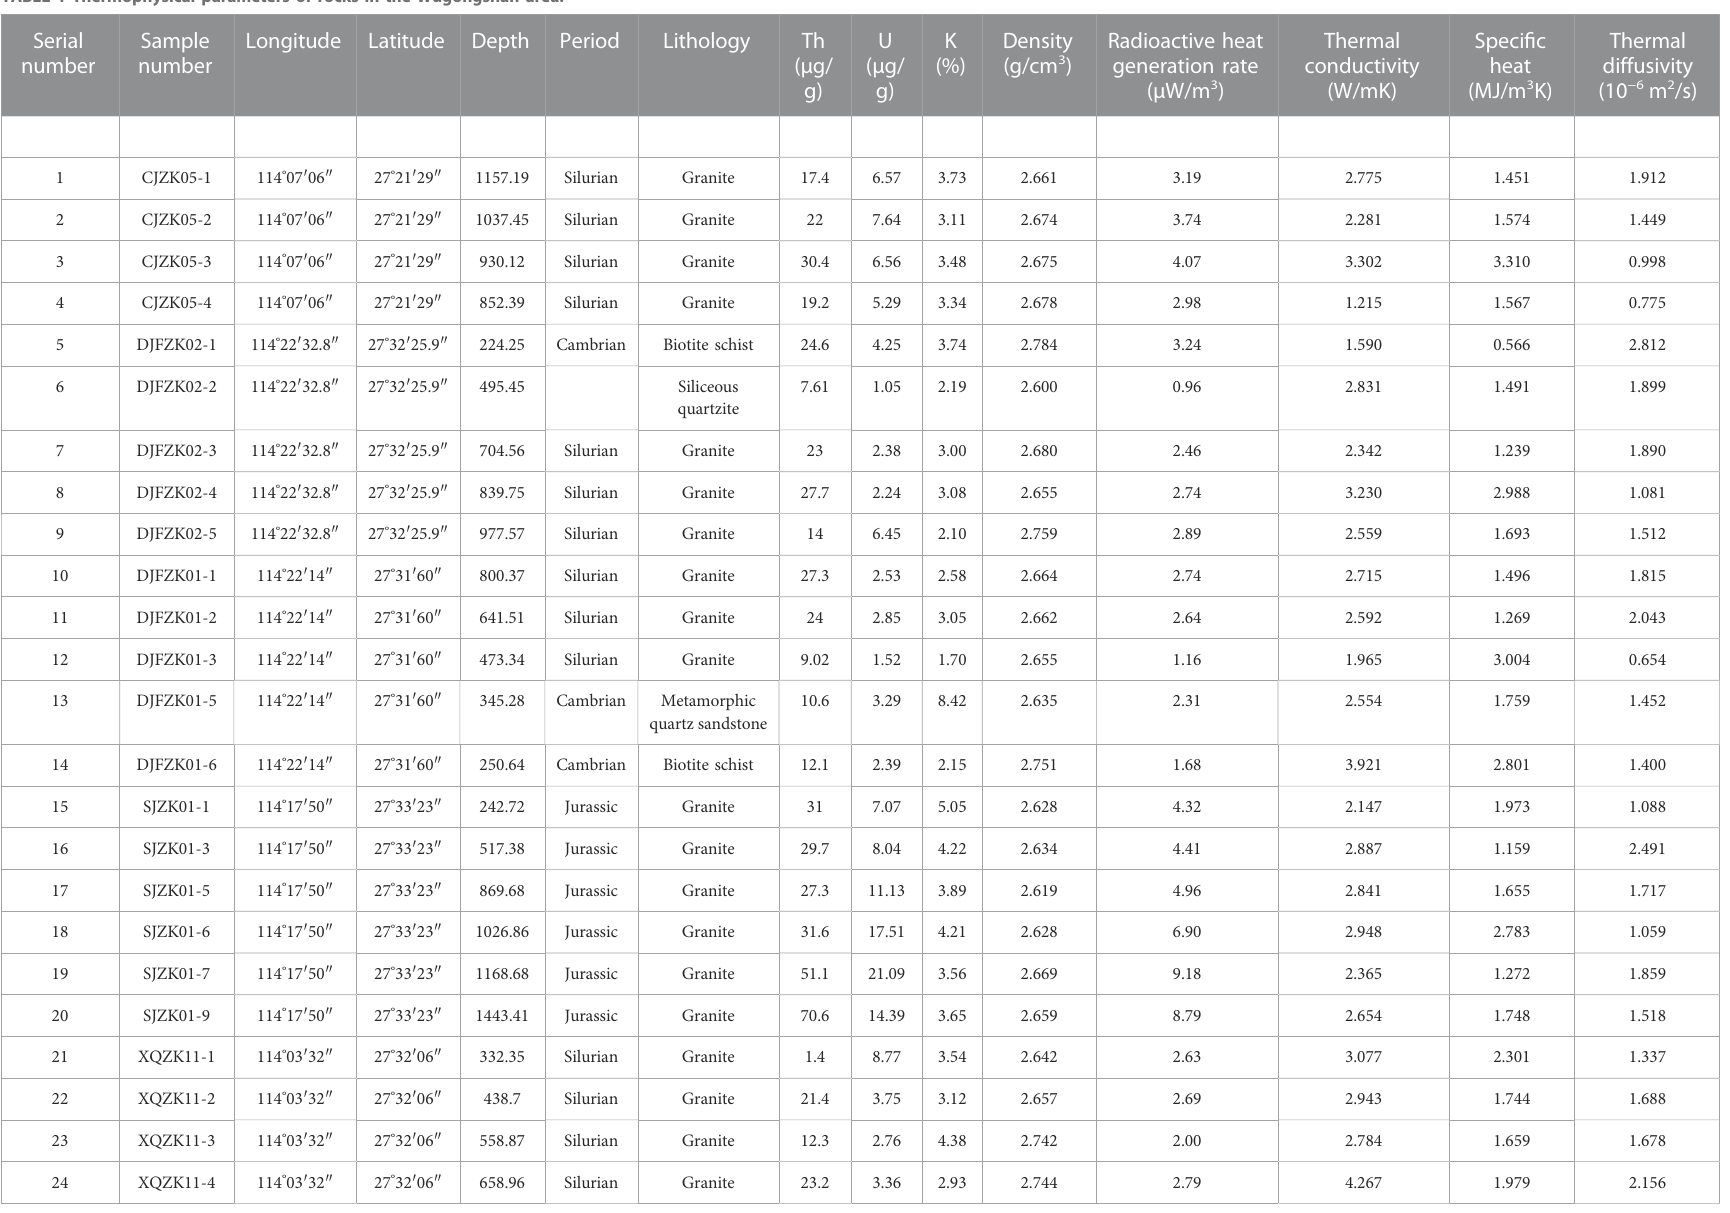
TABLE 1 Thermophysical parameters of rocks in the Wugongshan